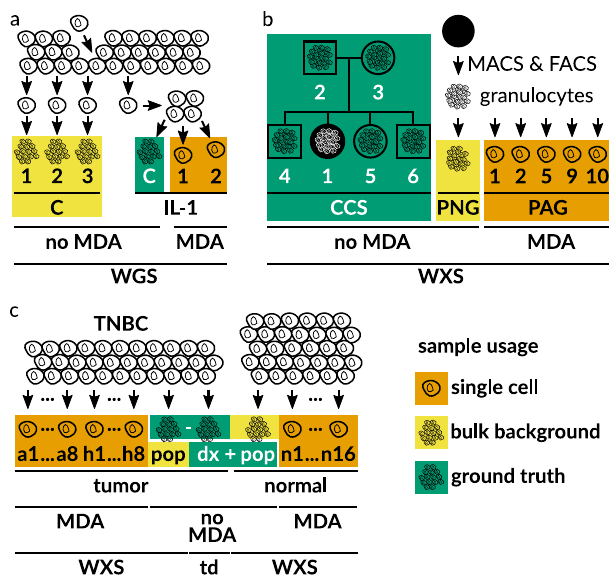
Fig. 4 Benchmark Datasets. For single cells, DNA was multiple displacement ampli fi ed (MDA). a Whole genome sequencing (WGS) dataset, generated from a clonal population started with an individual cell 28 , and expanded further downstream to generate different bulk samples (C1, C2, C3, and IL-1C). b Newly generated whole exome sequencing (WXS) dataset of blood cells. Ground truth genotypes of patient CCS1 were determined from sequencing data of family members (boxes male; circles female). Granulocytes were isolated from blood using magnetic and fl uorescence-activated cell sorting (MACS and FACS). c Whole exome sequencing (WXS) dataset from a triple-negative breast cancer (TNBC) patient 21 . For tumor cells (a1 to a8 and h1 to h8), the cell population (pop) sequencing of the normal sample was taken as the ground truth, including known clonal tumor-speci fi c somatic variants previously validated by deep targeted duplex (td, dx) sequencing 21 . For normal cells (n1 to n16), the cell population (pop) sequencing of the tumor sample was taken as the ground truth, after removing known clonal and subclonal tumor-speci fi c somatic variants previously validated by deep targeted duplex (td, dx) sequencing 21